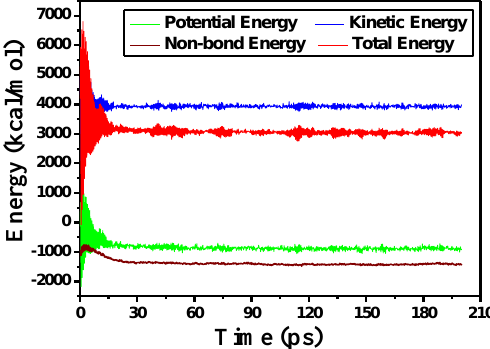
Figure 4. Variations in the energy of simulation models over time.